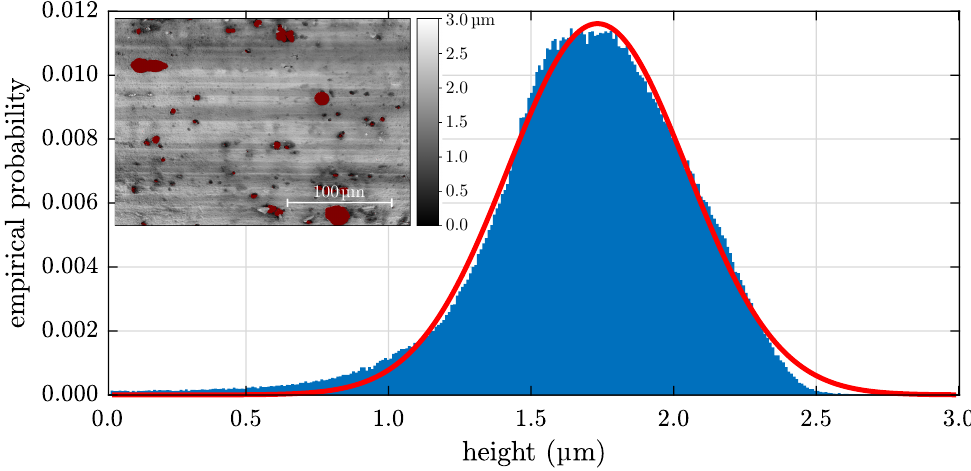
Figure 3. Height distribution of the Ref sample calculated from the laser scanning confocal microscopy (LSCM) image in the inset.